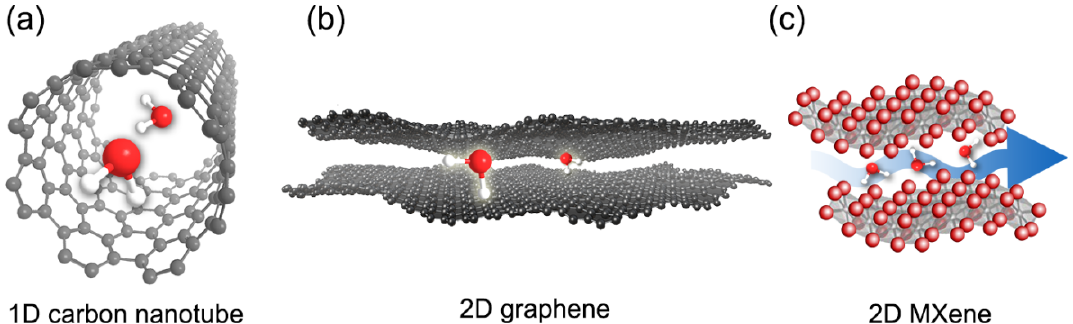
Figure 2. Illustration of 1D and 2D nanomaterials used for electrically responsive membranes: ( a ) carbon nanotube, ( b ) graphene, and ( c ) MXenes, showing water transport through them.